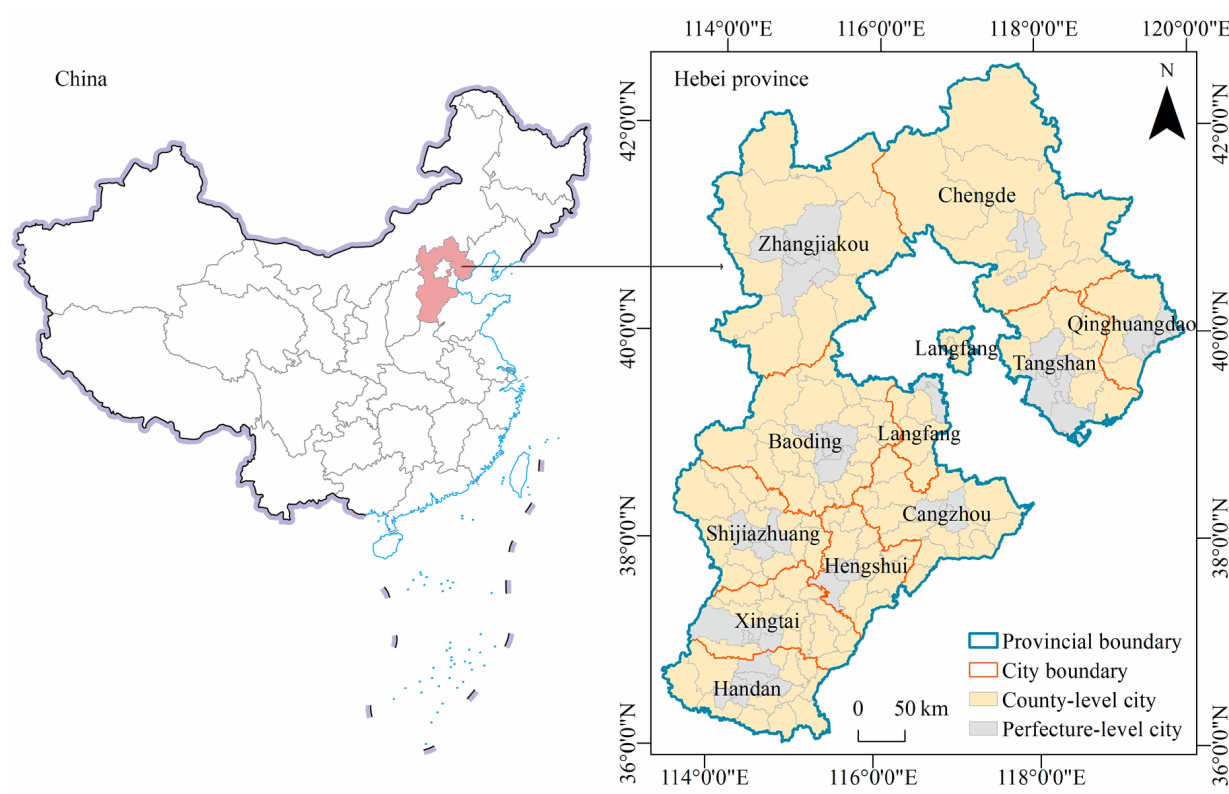
Figure 1. Location map of the study area.